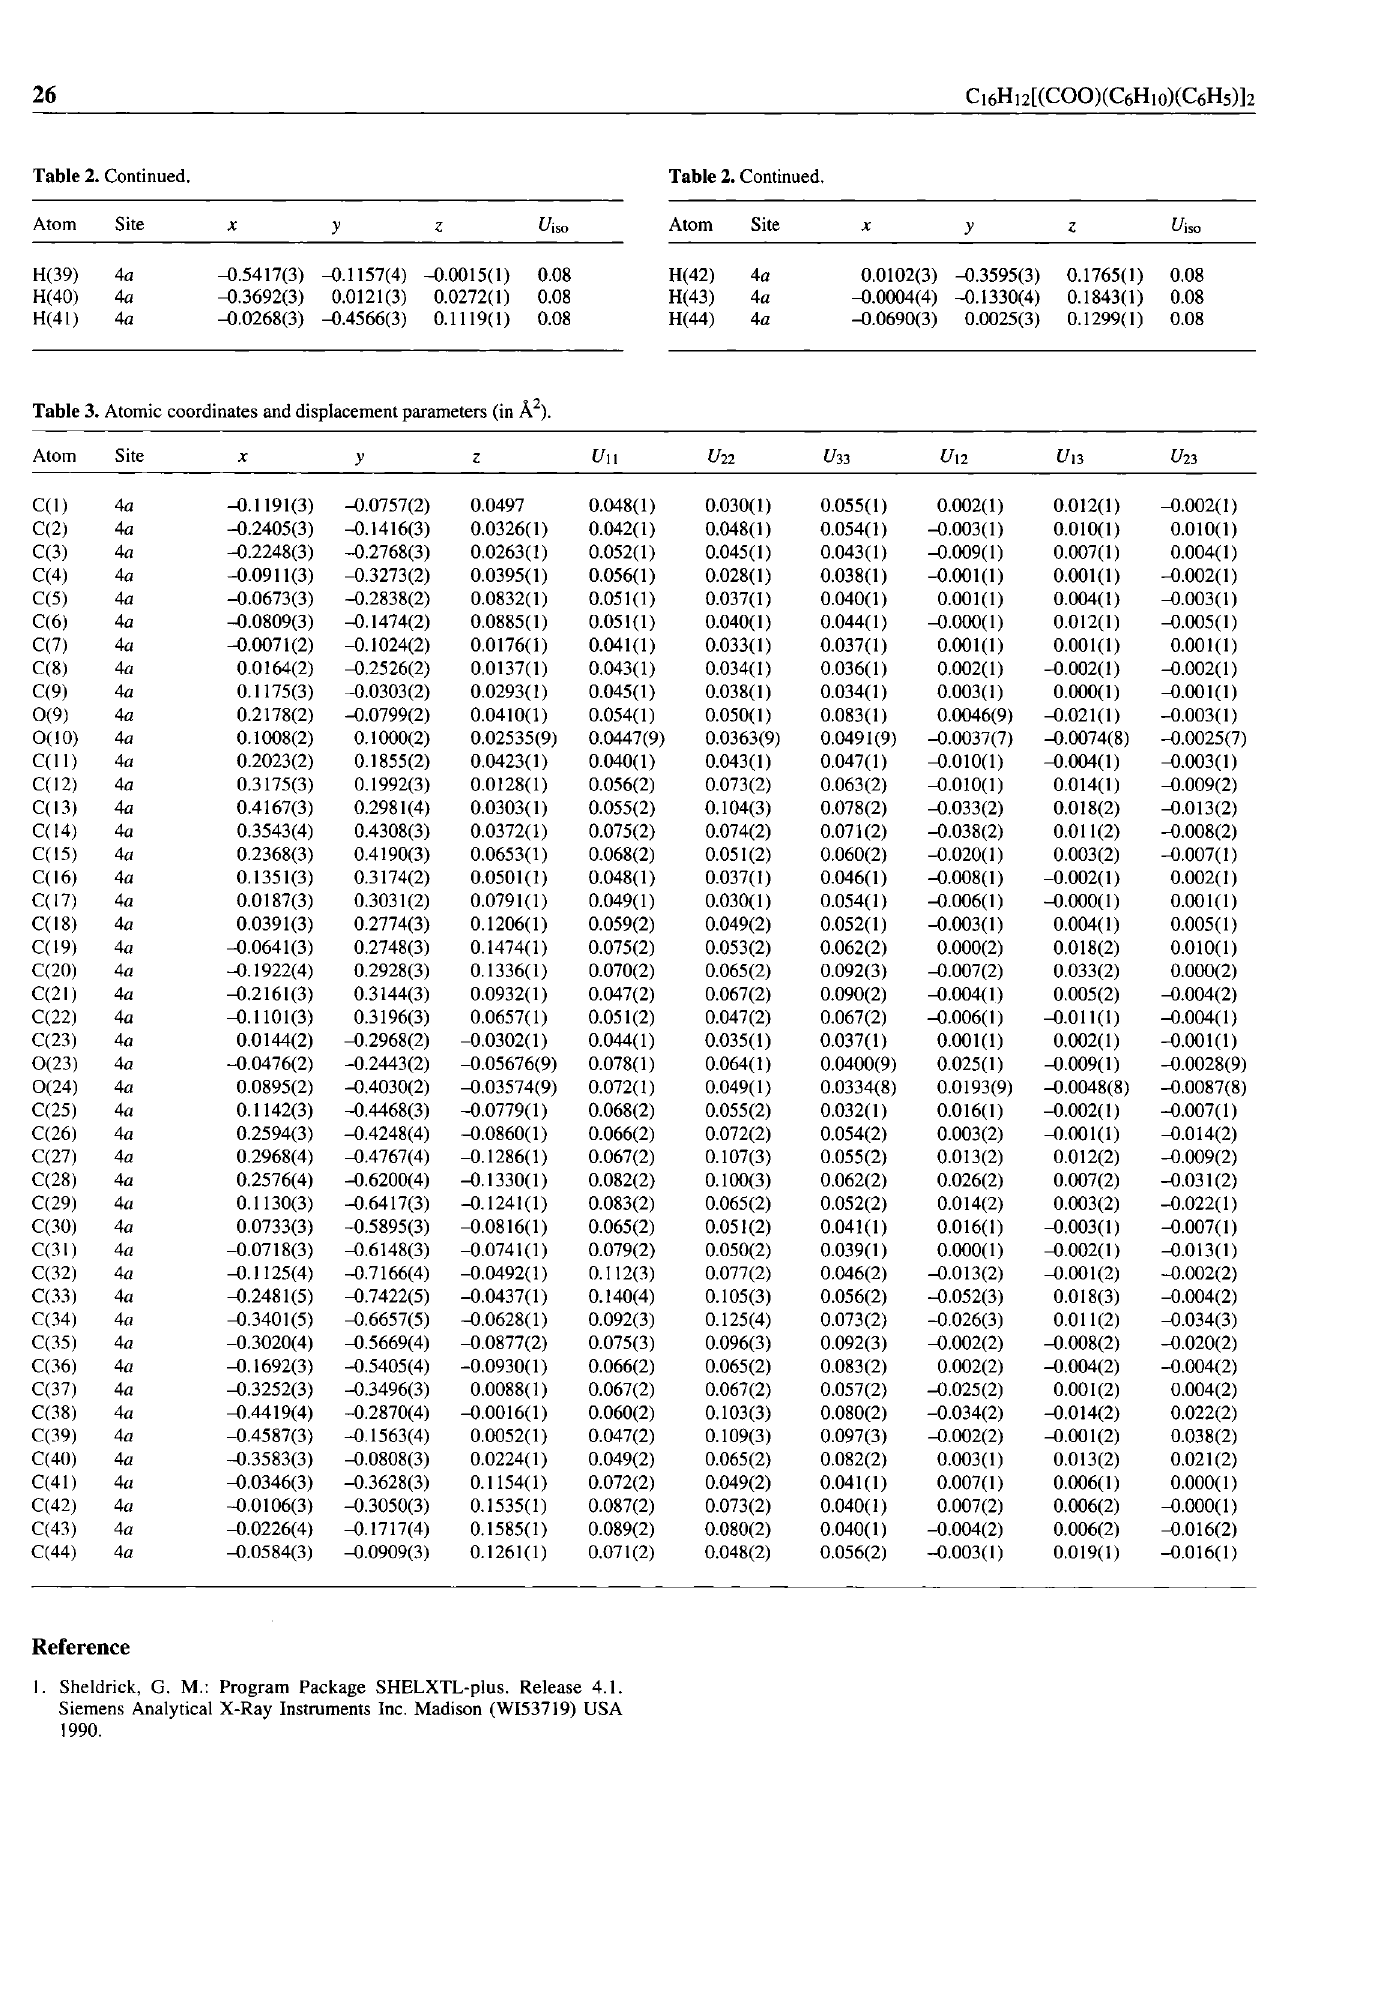
Table 3. Atomic coordinates and displacement parameters (in Ä 2